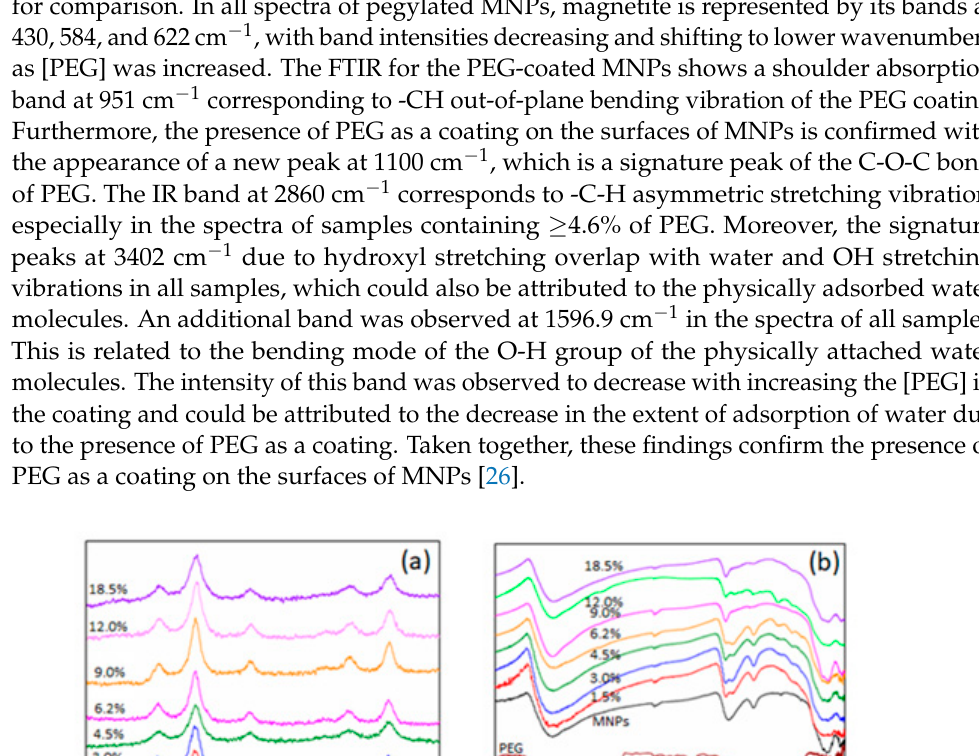
Scheme 1. Mechanism of the formation of PEG and hydrated layers onto MNPs surfaces .